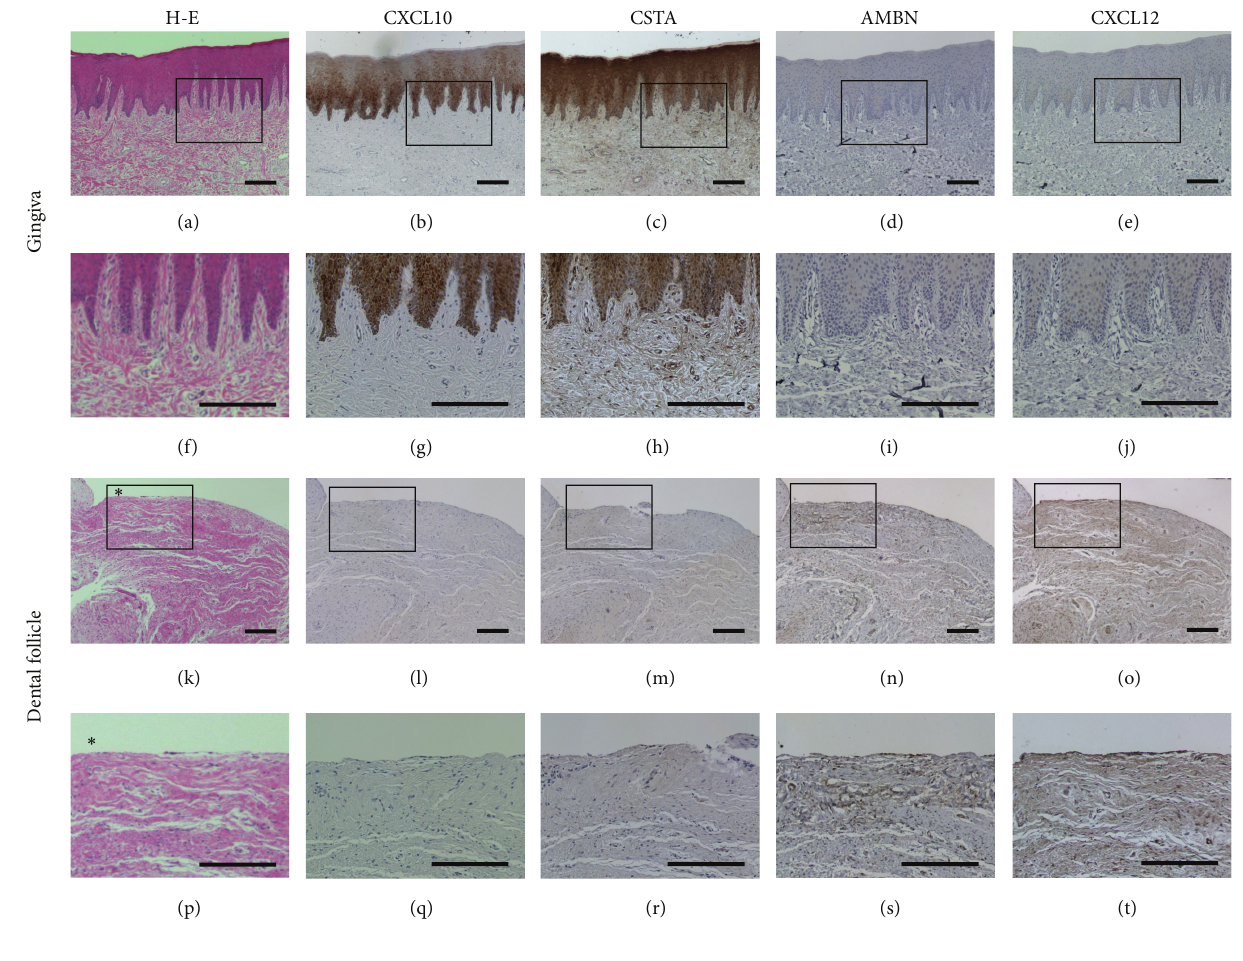
Figure 3: Verification of microarray results by immunohistochemical (IHC) staining. Hematoxylin-eosin staining in the gingiva (a, f) and dental follicles (DFs) (k, p) (asterisk: outer border neighboring alveolar bone). IHC staining for CXCL10 in the gingiva (b, g) and DFs (l, q). IHC staining for CSTA in the gingiva (c, h) and DFs (m, r). The expression of CXCL10 and CSTA was stained markedly in the gingival epithelium. The IHC staining for AMBN in the gingiva (d, i) and DFs (n, s). AMBN was stained around the outer layer of the DFs. The IHC staining for CXCL12 in the gingiva (e, j) and dental follicles (o, t). CXCL12 was stained in both a cellular layer and the collagenous connective tissue of DFs (scale bars: 200 𝜇